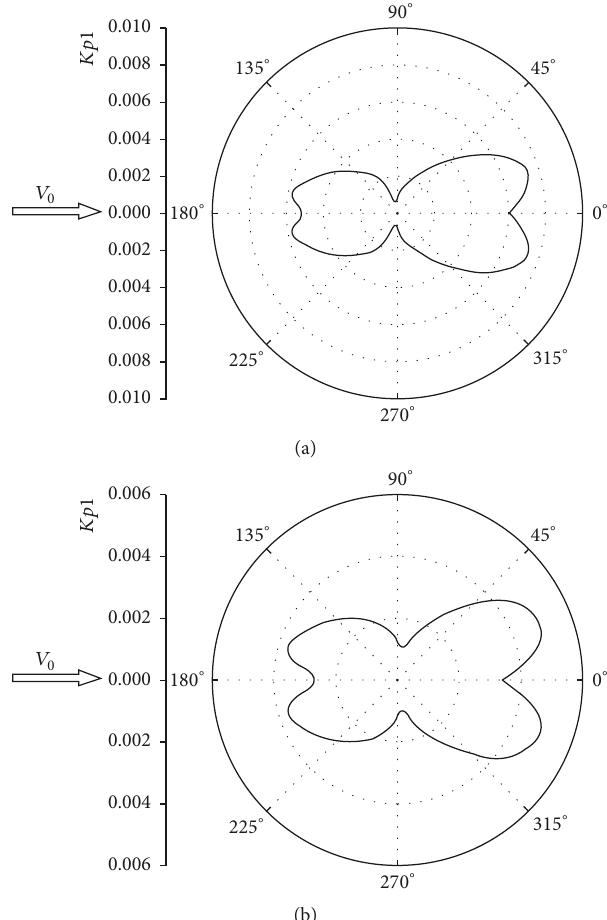
Figure 20: Two-dimensional distributions of the fluctuating pres- sures of the forward and rear propellers of CRP. (a) Forward propeller. (b) Rear